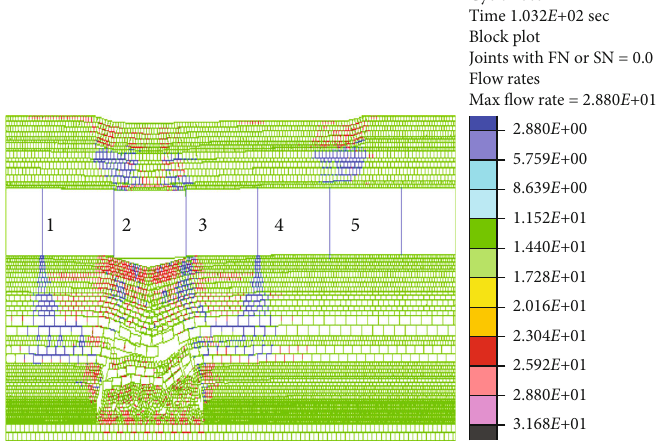
Figure 10: The fl ow distribution in initial caving of key layer